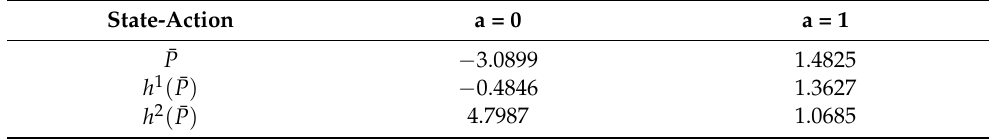
Table 1. Convergent Q -table based on Q -learning from the perspective of the